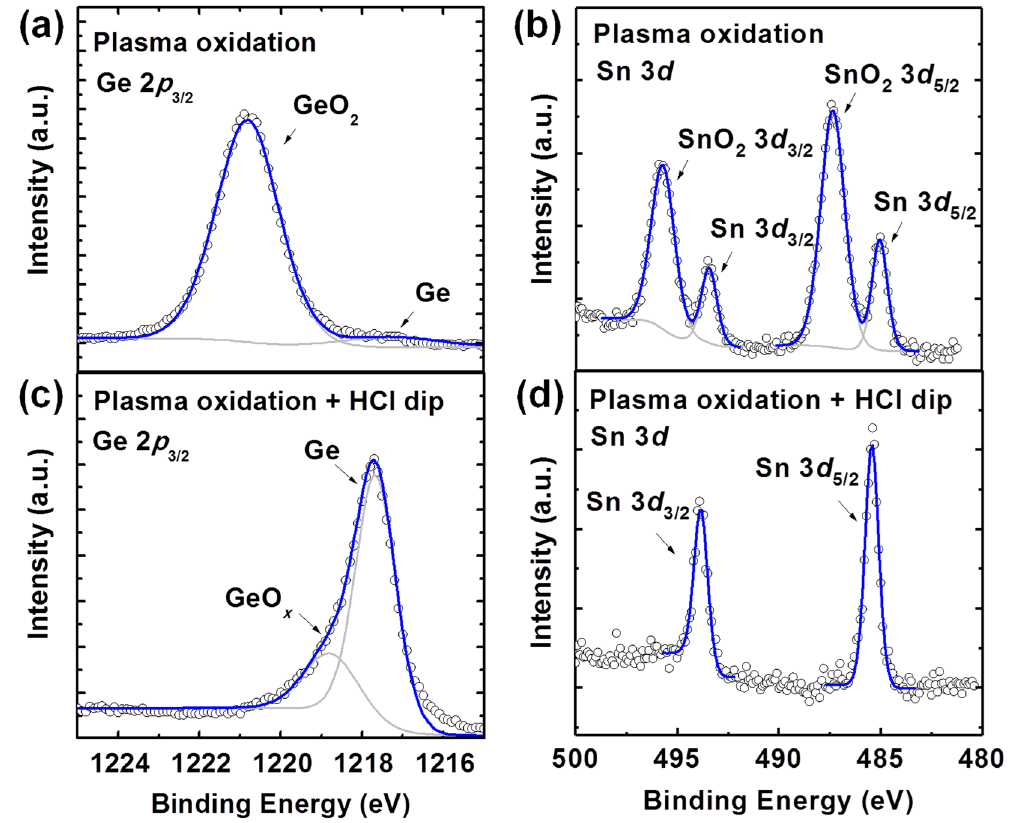
Figure 2. ( a ) Ge 2 p 3/2 and ( b ) Sn 3 d XPS spectra of Ge 0.875 Sn 0.125 /Ge(001) sample after plasma oxidation. ( c ) Ge 2 p 3/2 and ( d ) Sn 3 d XPS spectra of oxidized Ge 0.875 Sn 0.125 /Ge(001) sample after HCl dipping. XPS results indicate the oxide formation and removal in one digital etch Digital Etch of Ge and Ge Sn layers. High-resolution X-ray diffraction (HRXRD) was used to inves- 1 − x x tigate the Sn content and crystallinity of the Ge 1 − x Sn x samples. Figure 3a shows the HRXRD scans around the 004 diffraction point for the Ge 0.875 Sn 0.125 /Ge samples before and after digital etch. Clear GeSn and Ge peaks can be identified for the as-grown Ge 0.875 Sn 0.125 sample, and the presence of interference fringes surrounding the GeSn peak suggests good interface quality. The full width at half maximum (FWHM) of the GeSn diffraction peak increases with increasing etch cycles, which indicates the decrease of Ge 0.875 Sn 0.125 layer thickness according to Scherrer’s formula 43 . This is consistent with the increasing interval of the interference fringes after digital etch. After an 8-cycle digital etch, the GeSn peak moves slightly towards the Ge peak. The Sn content can be calculated to be 11.7%, which corresponds to a Sn content decrease of approximately 0.8%. On the other hand, X-ray reflectivity (XRR) measurements have been performed on the Ge 1 − x Sn x samples before and after digital etch. XRR can be used to determine thickness of thin film with high accuracy by ana- lysing X-ray reflection intensity curves from grazing incident X-ray beam. As a non-destructive technique, no additional lithographic patterning is needed for etch depth calibration. Figure 3b shows the experimental (open black circle) and simulated (blue curve) XRR curves of the as-grown Ge 0.875 Sn 0.125 , the Ge 0.875 Sn 0.125 after plasma oxidation, and the Ge 0.875 Sn 0.125 after HCl dipping. The thickness of the as-grown Ge 0.875 Sn 0.125 film is 30.7 ± 0.2 nm, which can be obtained by fitting the reflected X-ray intensity versus incident angle. The thickness of the Ge 0.875 Sn 0.125 film decreases with increasing number of digital etch cycles. After a 4-cycle digital etch and plasma oxidation, the thickness of Ge 0.875 Sn 0.125 film drops to 19.4 ± 0.2 nm. The etch rate can be estimated to be 2.2 nm/cycle. In addition, the thickness of Ge 1 − x Sn x oxide formed by plasma oxidation can be also extracted by XRR, which is 3.9 ± 0.2 nm. Based on the molar mass and density of Ge and GeO 2 , for every 2.2 nm-thick Ge consumed, 3.97 nm-thick GeO 2 will appear. This is consistent with the XRR results. Figure 4a shows the etched layer thickness as a function of etch cycle number for Ge 1 − x Sn x samples with vari- ous Sn content. The RF power is fixed at 250 W, and the plasma oxidation time is fixed at 120 s. The etched thick- ness for the Ge 1 − x Sn x samples was extracted from XRR, while that for the GeOI was obtained from ellipsometry measurements. Good linear fits can be observed in all the samples, which confirm that a consistent depth of Ge or Ge 1 − x Sn x is etched away each cycle. The etch rate extracted from the slope is ~2.2, ~1.9, and ~1.4 nm/cycle for the Ge 0.875 Sn 0.125 , Ge 0.95 Sn 0.05 , and Ge, respectively (Fig. 4b). It was reported that SiGe alloys had higher oxidation rates than Si under thermal oxidation conditions 44, 45 . This enhancement under thermal oxidation increases with increasing initial Ge concentration in the alloy. Therefore, it could be explained in terms of the Si − Ge bond being weaker than the Si − Si bond. Similarly, the presence of Sn atoms results in weaker Ge-Sn bonds than Ge-Ge 3 Scientific RepoRts | 7: 1835 | DOI:10.1038/s41598-017-01449-1